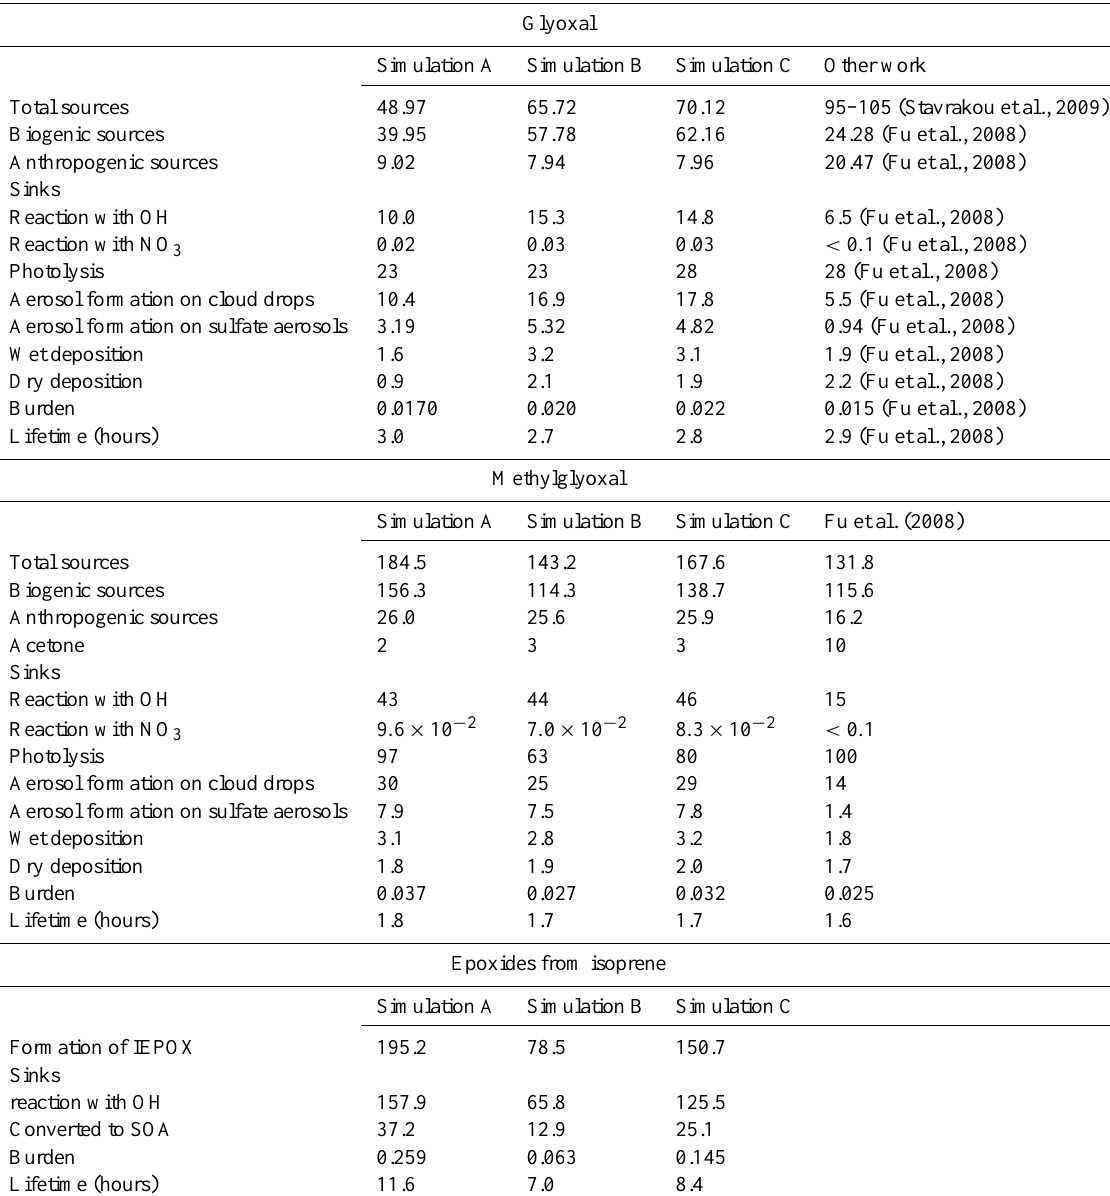
Table 6. Budgets for secondary organic aerosol precursors reacting on acidic aerosols and cloud drops (Tgyr − 1